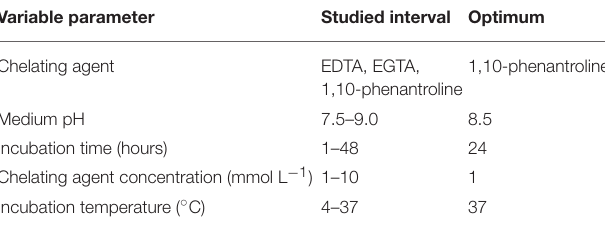
TABLE 1 | Experimental conditions for the extraction of zinc from